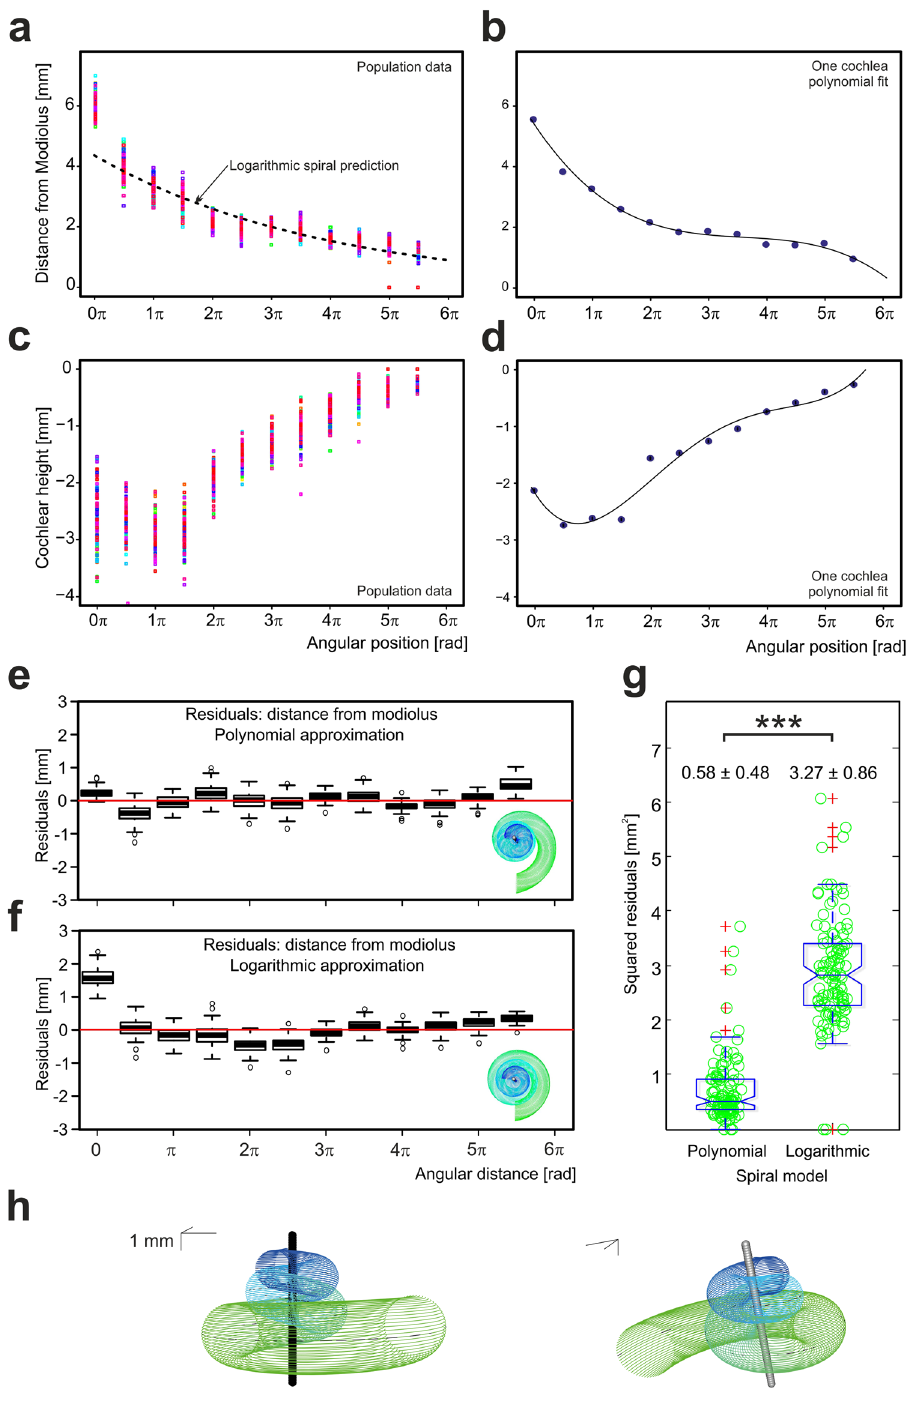
Figure 4. Quantified shape of the cochlea along the lateral wall and the vertical profile. ( a ) Distance of the lateral wall from the modiolus as a function of angular position, data of individual cochleae shown in different colors, logarithmic prediction shown as the dotted line. The data extensively deviate from the logarithmic prediction near 0 π and 2 π . ( b ) One cochlea fitted with the polynomial function. In contrast to the logarithmic function, the polynomial function fits the data of individual cochleae optimally. ( c ) Cochlear vertical position (height) as a function of angular position. Shown are all cochlea from the study, different specimen shown in different colors. ( d ) The fit of the data from one typical cochlea with a polynomial function. Here the fit was slightly weaker than in ( b ). ( e ) Results of leave-one-out technique in fitting the polynomial and logarithmic spirals to the present sample of human cochleae. Fit residuals as a function of angular position for the polynomial spiral document a good fit, with small deviations in π /2 and in the apex of the cochlea. The inset shows the typical geometry viewed from the ventral aspect very similar to the human cochlea. ( f ) Fit residuals for the logarithmic spiral. Even with the best possible fits there was a significant error at the very base,